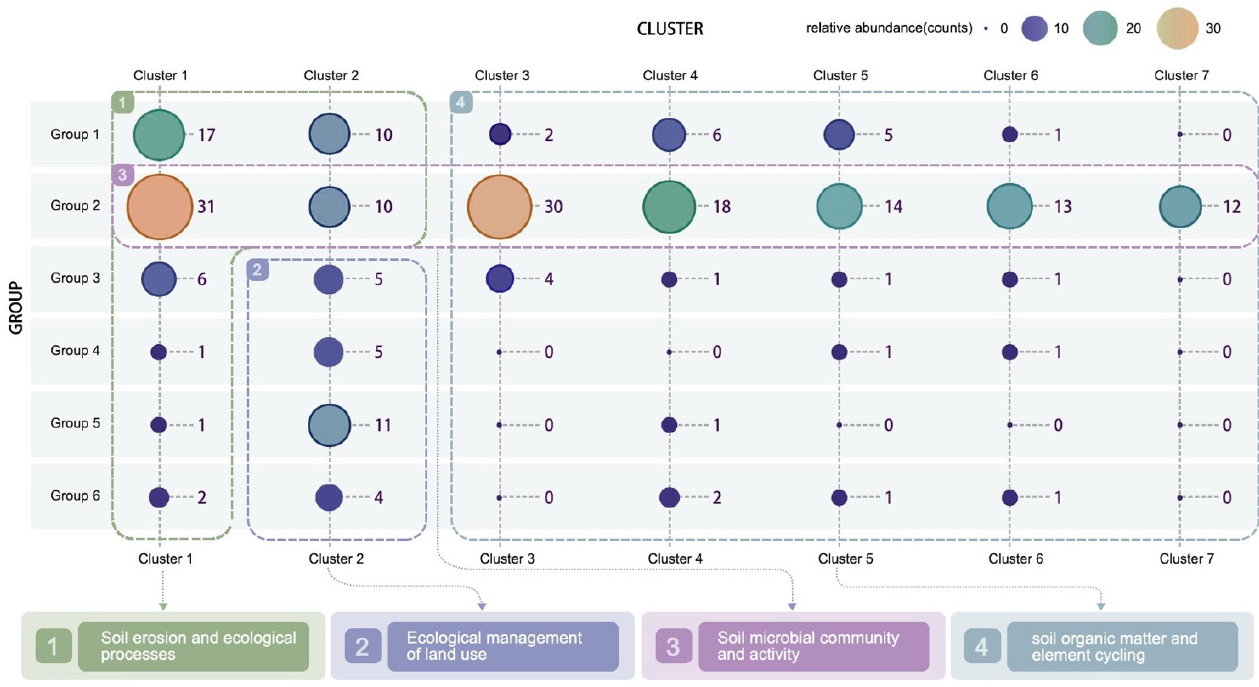
Figure 7. Number distributions of high-frequency phrase overlaps of clusters and groups. The size of the circle represents the words that the cluster and group repeats among the 218 words.